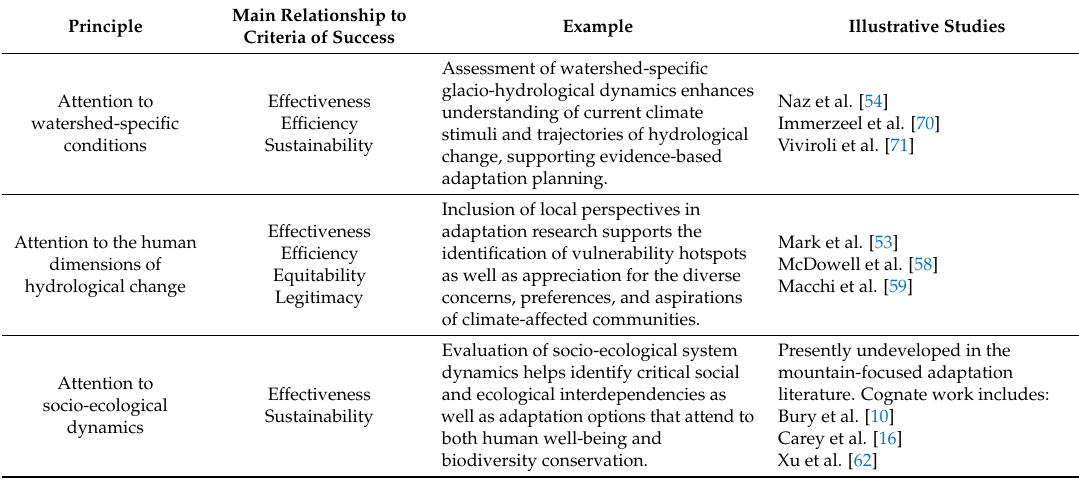
Table 1. Relationship of principles to criteria of successful